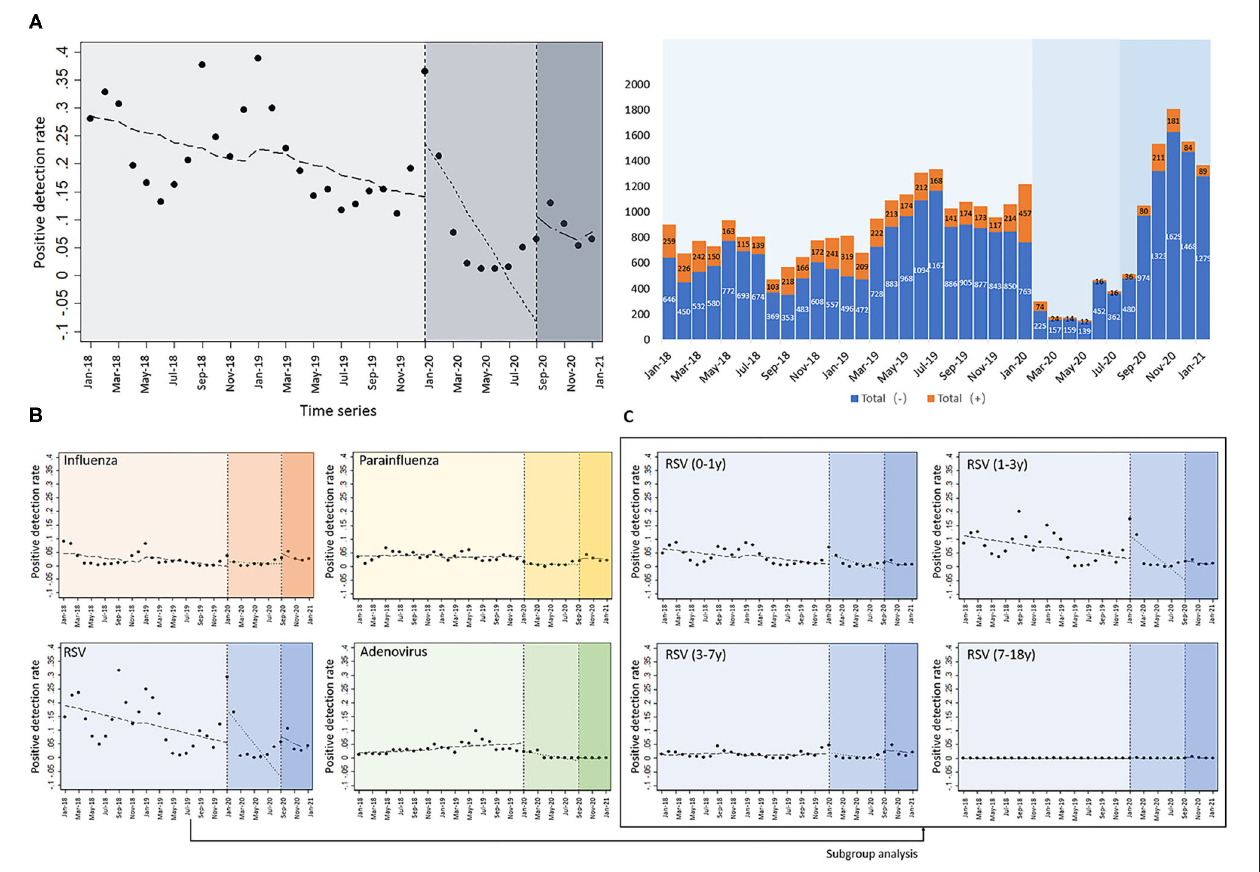
FIGURE 2 | Interrupted time series analysis of positive detection rates of four common respiratory viruses. (A) The absolute number of detections and detection rates of the four respiratory viruses after the implementation of isolation and school closure measures, after adjusting for seasonal factors; (B) detection rates of influenza virus, parainfluenza virus, and adenovirus; (C) subgroup analysis of RSV positive detection rates according to the different age